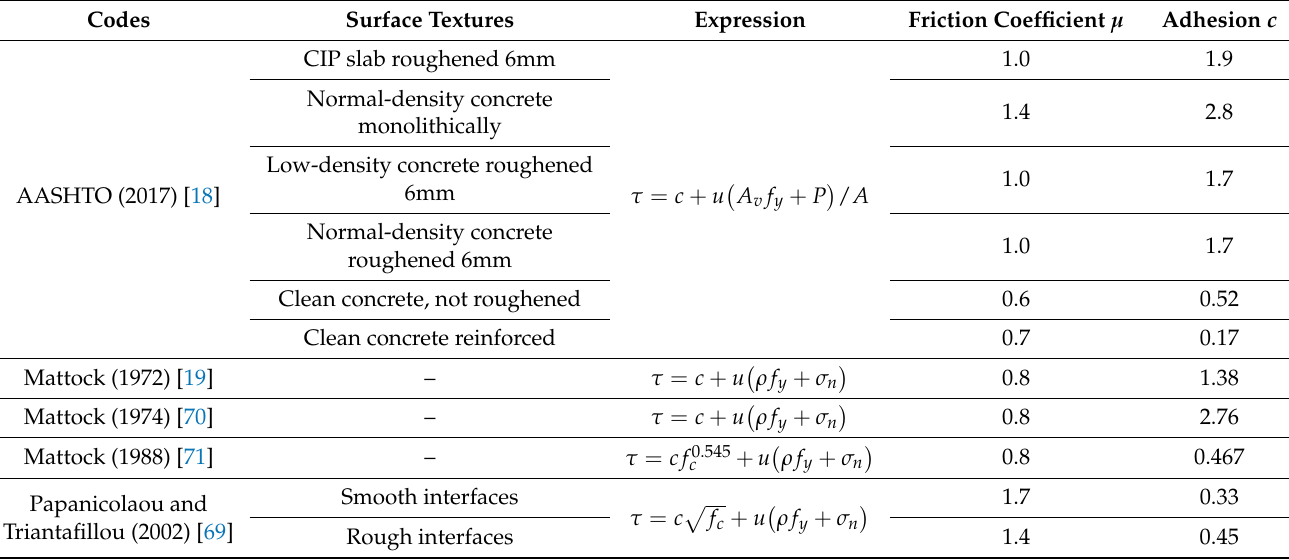
Table 7. Relevant formulas in